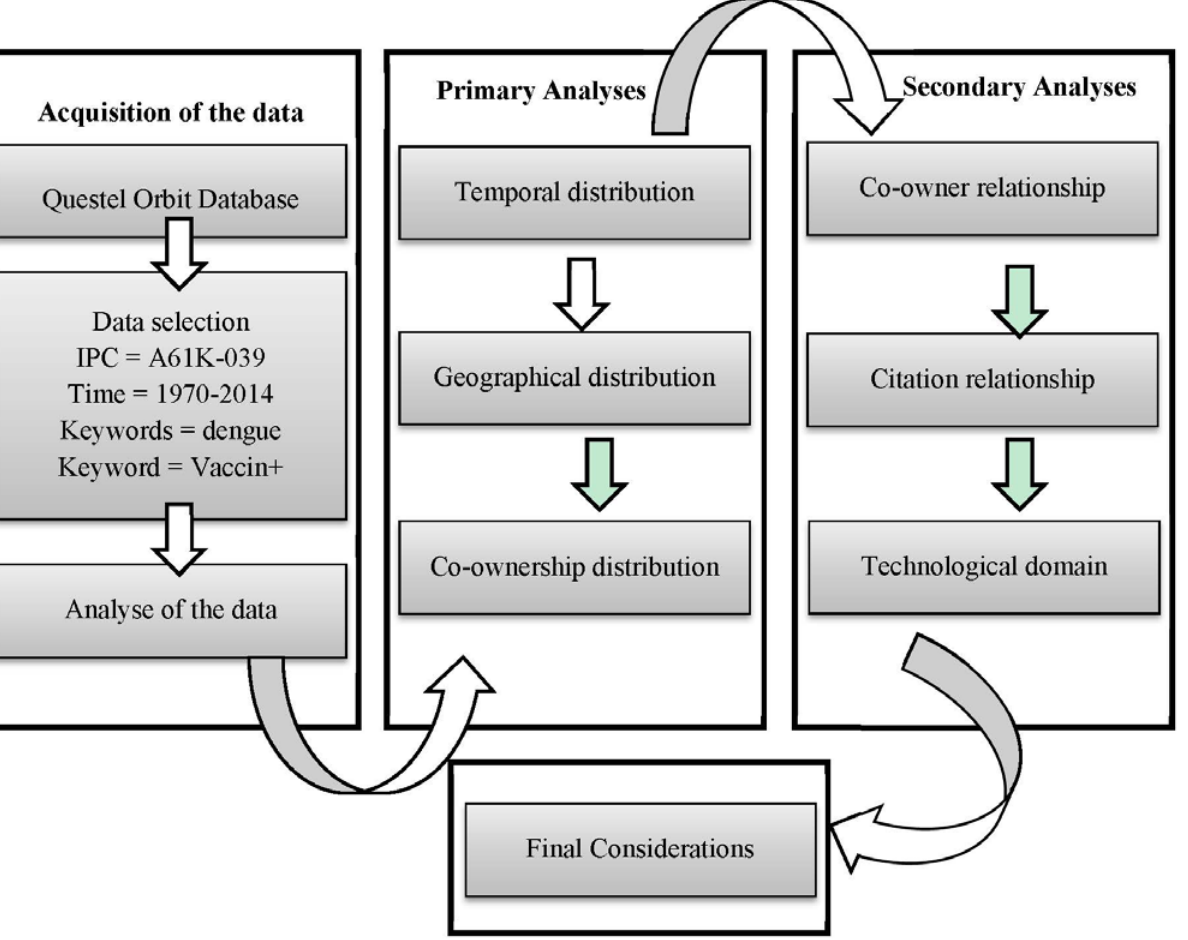
Figure 1. Type, acquisition and treatment of the data under